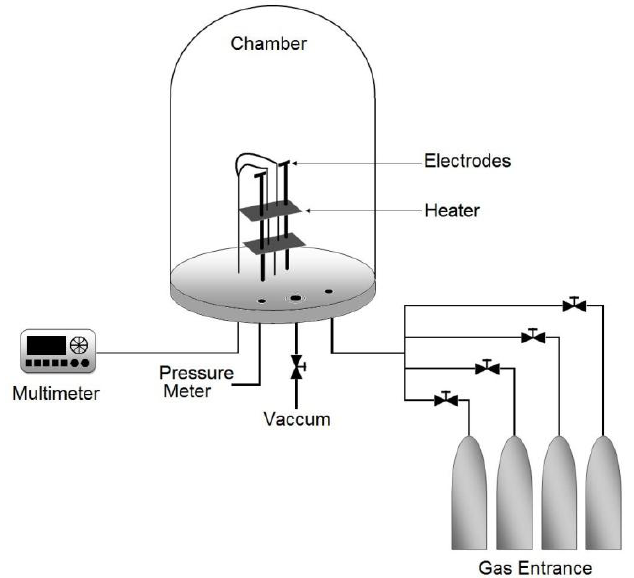
Figure 1. Schematic diagram of the system used to measure electrical properties in controlled atmospheres and